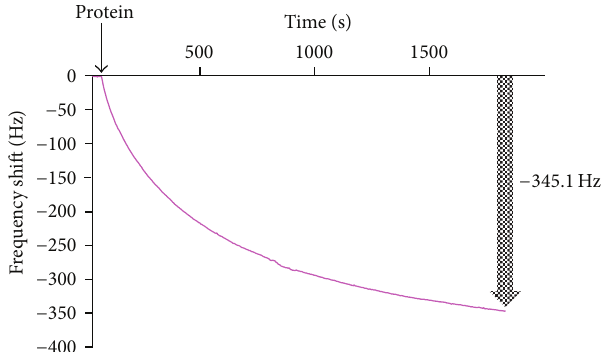
Figure 1: Change in frequency of QCM after protein injection. Changeinfrequencyofthequartzcrystalmicrobalance(QCM)after protein injection. In this case, the amount of protein adsorbed is 345.1 × 0.62 = 344.48 ng cm −2 onto the QCM